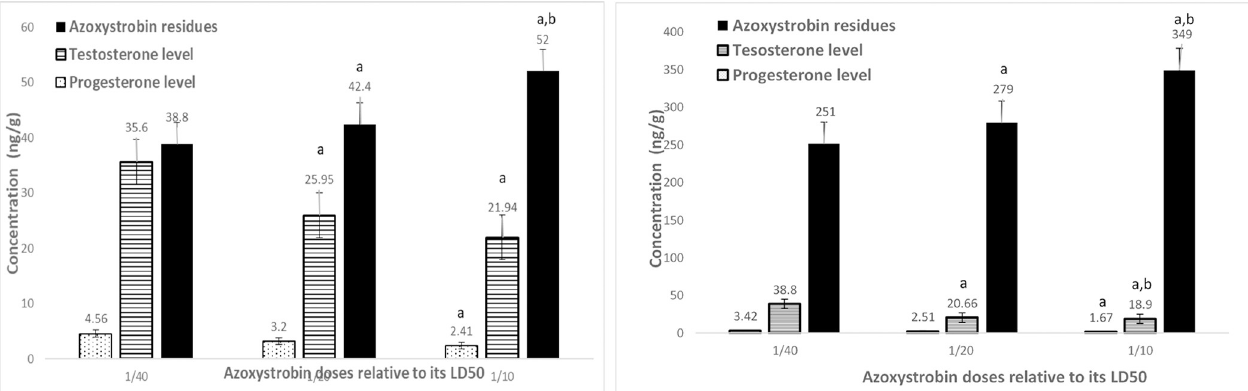
Fig 9. A. Testis testosterone and progesterone levels as well as azoxystrobin residues after a month treatment of different azoxystrobin doses on male rats. Data presented as mean S.E. a Significant difference as compared to 1/40 LD 50 , and b significant difference as compared to 1/20 of LD 50 (n = 4, P � 0.05). B: Testis testosterone and progesterone levels as well as azoxystrobin residues after 2 months treatment of different azoxystrobin doses on male rats. Data presented as mean S.E. a Significant difference as compared to 1/40 LD 50 , and b significant difference as compared to 1/20 of LD 50 (n = 4, P � 0.05).